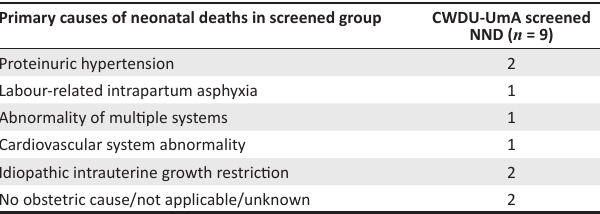
TABLE 2b: Primary causes of stillbirths and neonatal deaths for the continuous wave Doppler ultrasound of the umbilical artery screened study group. Primary causes of neonatal deaths in screened